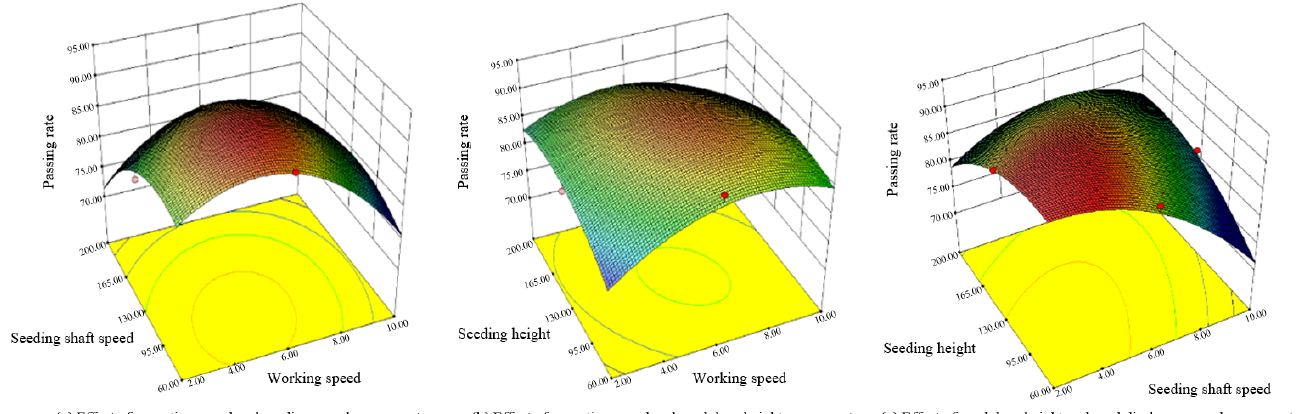
Figure 4. Surface Chart of Performance Impact of Air Suction Seed Metering Device.